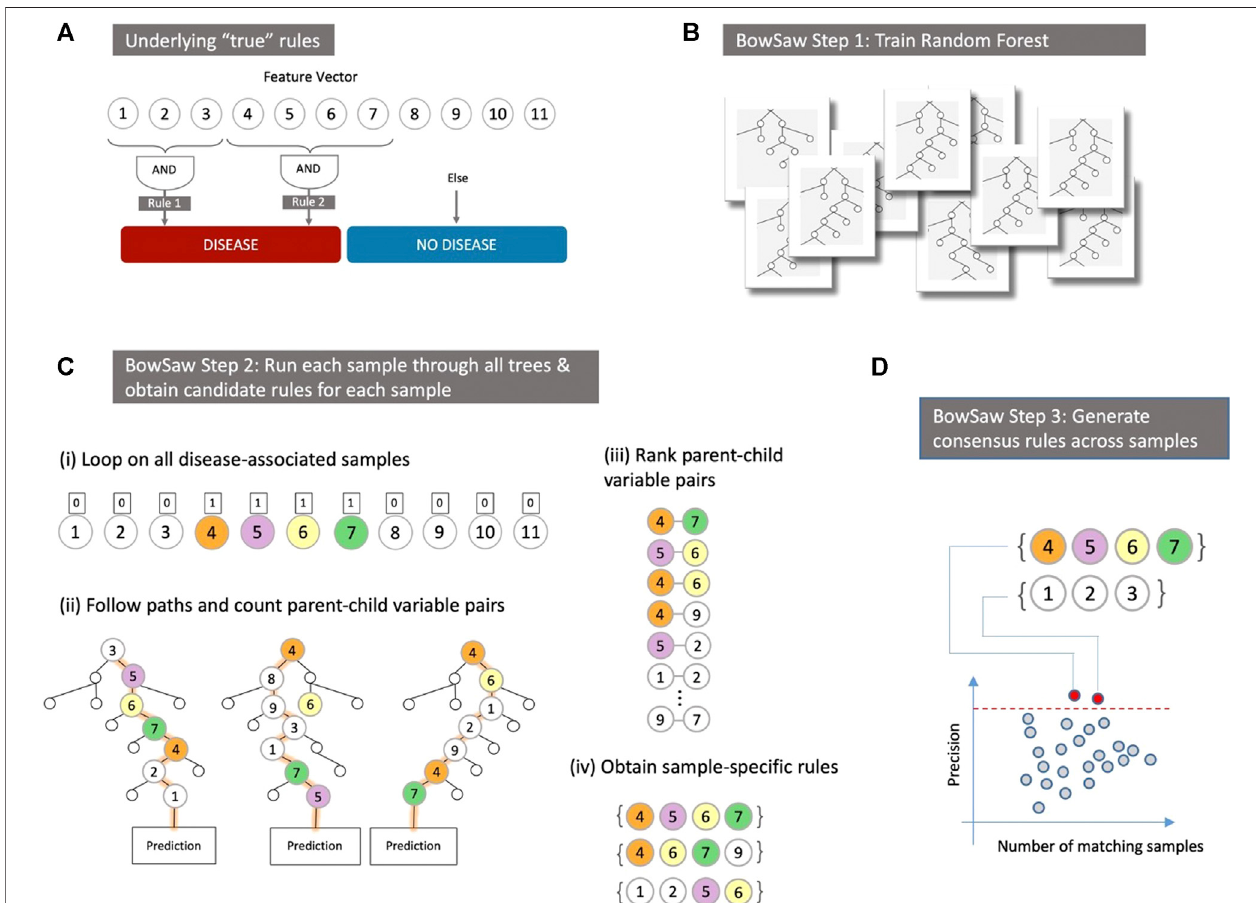
FIGURE 1 | (A) In a hypothetical dataset there are two phenotype labels –“ Disease ” and “ No Disease ” that we wish to discriminate based on input predictor variables. In this example, there are two distinct high-order patterns that both confer the same “ Disease ” phenotype. Our goal is to identify a potentially diverse set of patterns (or, in this simpli fi ed case, all patterns) that are associated with the “ Disease ” label. (B) Instead of exhaustively evaluating variable combinations we leverage the structure that emerges from an ensemble of decisions trees like those produced by a trained random forest. (C) For each sample with the observed phenotype “ Disease ” we fi rst identify the vector containing its input values (i). Then follow the paths it takes downs each tree that attempts to predict its class and record the frequency of parent-child variable pairs (ii). Next, we rank parent-child variable pairs in descending order of frequency (iii). Finally, we use a great search to construct a sample-speci fi c rule that is fully associated with the “ Disease ” phenotype (iv). (D) All sample-speci fi c rules are evaluated in order to obtain a consensus set of rules that combined account for all samples with the “ Disease ”